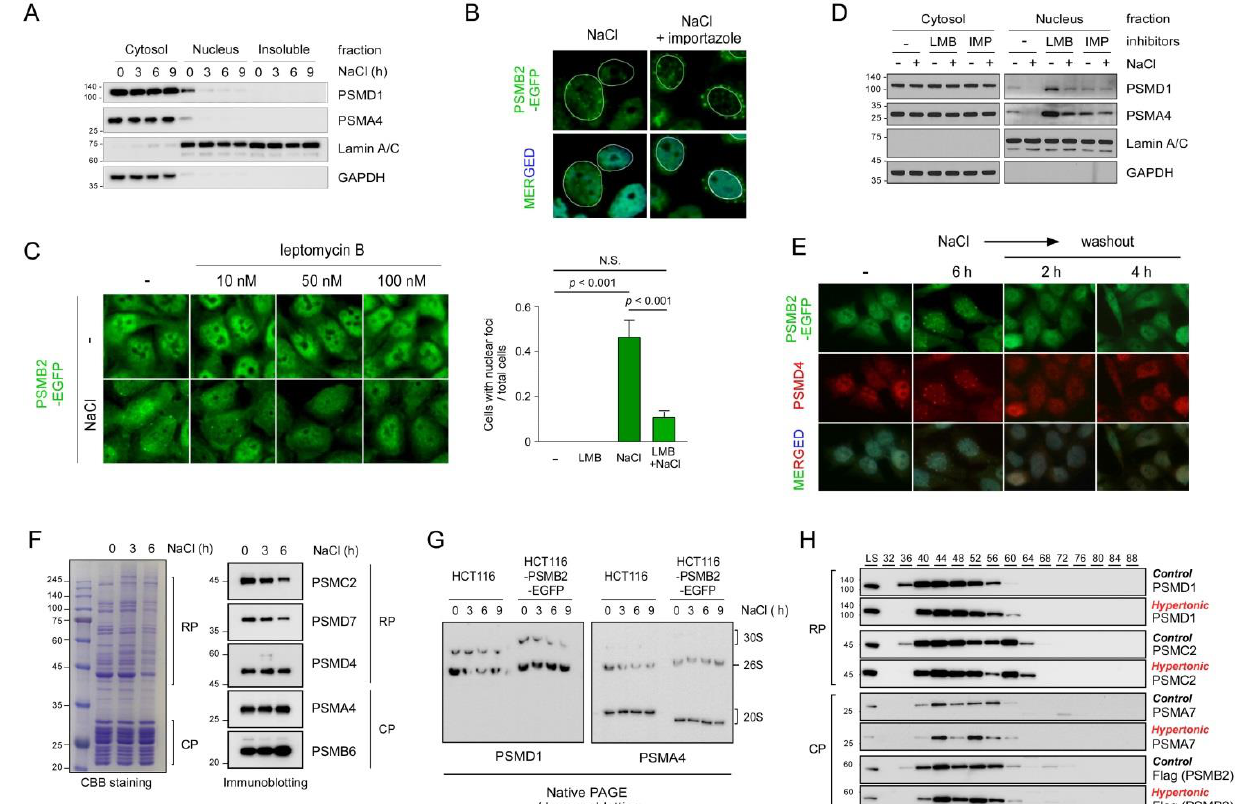
Figure 3. The nucleocytoplasmic transport of 26S proteasomes is implicated in the nuclear proteasome foci formed during hyperosmotic stress. ( A ) Immunoblotting analysis of a CP subunit (PSMA4) and a RP subunit (PSMD1) was conducted using the cytosolic and nuclear fractions of whole-cell lysates from hyperosmosis-stressed HCT116-PSMB2-EGFP cells. ( B ) Cells were treated with 200 mM NaCl in the absence or presence of 40 µM importazole (a nuclear import inhibitor) for 6 h. White circles indicate the nuclear membrane. ( C ) As in B, except that the cells were treated with the indicated concentrations of leptomycin B (a nuclear export inhibitor). Data are analyzed by one-way ANOVA with the Tukey’s multiple comparison tests. ( D ) As in A, except that the cells were cotreated with importazole (40 µM) or leptomycin B (50 nM). ( E ) During washing out NaCl with a normal medium, changes in PSMB2-EGFP and PSMD4-positive immunostaining signals were monitored. ( F ) Human 26S proteasomes were affinity-purified from HEK293 cells stably overexpressed PSMB2-biotin before and after treatment with 200 mM NaCl. The purified proteasomes analyzed by SDS-PAGE followed by Coomassie brilliant blue (CBB) staining and immunoblotting. ( G ) The integrity and level of proteasomes were examined using non-denaturing (native) PAGE and the whole-cell lysates from HCT116 cells and HCT116-PSMB2-EGFP cells. ( H ) Size-exclusion chromatography of whole-cell extracts from HCT116-PSMB2-EGFP cells treated with NaCl (200 mM, 6 h). Components of 26S proteasomes were examined by SDS-PAGE/immunoblotting. Consistent with the microscopic data, the levels of proteasome subunits were found